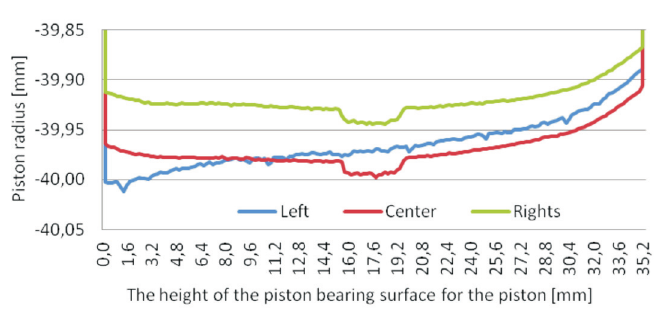
Fig. 2. The actual profile of the piston bearing surface with a H shape graphite layer